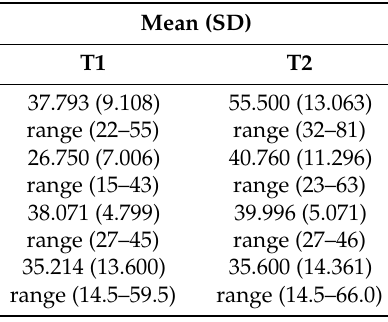
Table 1. Demographic Statistics of the